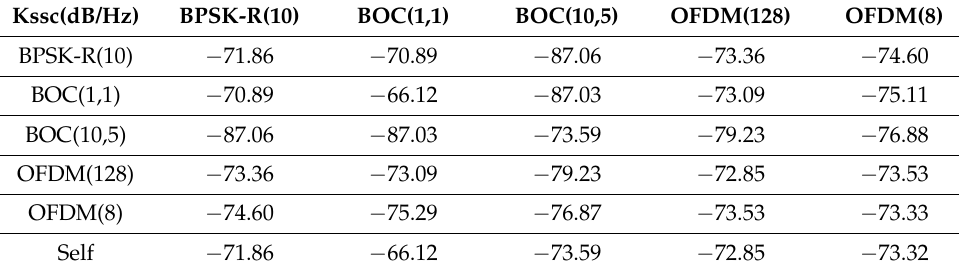
Table 1. The SSCs of several navigation signals.